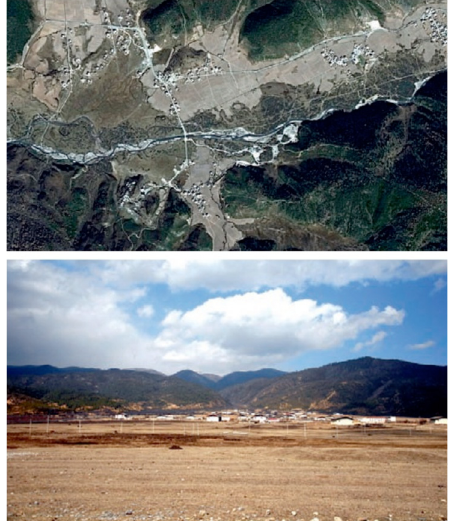
Fig. 1. Hongpo Village, Jiantan Town.